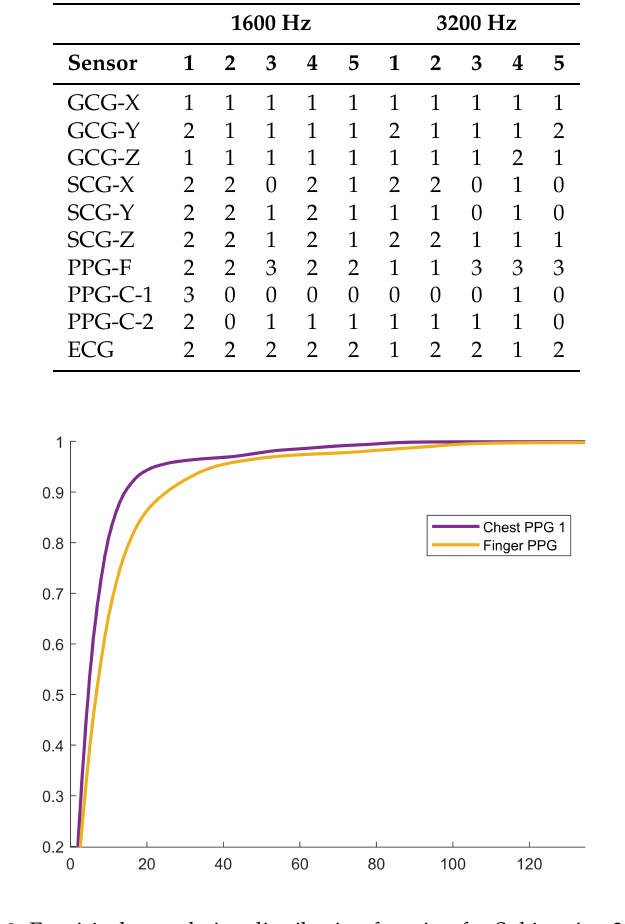
Figure 9. Empirical cumulative distribution function for Subject 4 at 3200